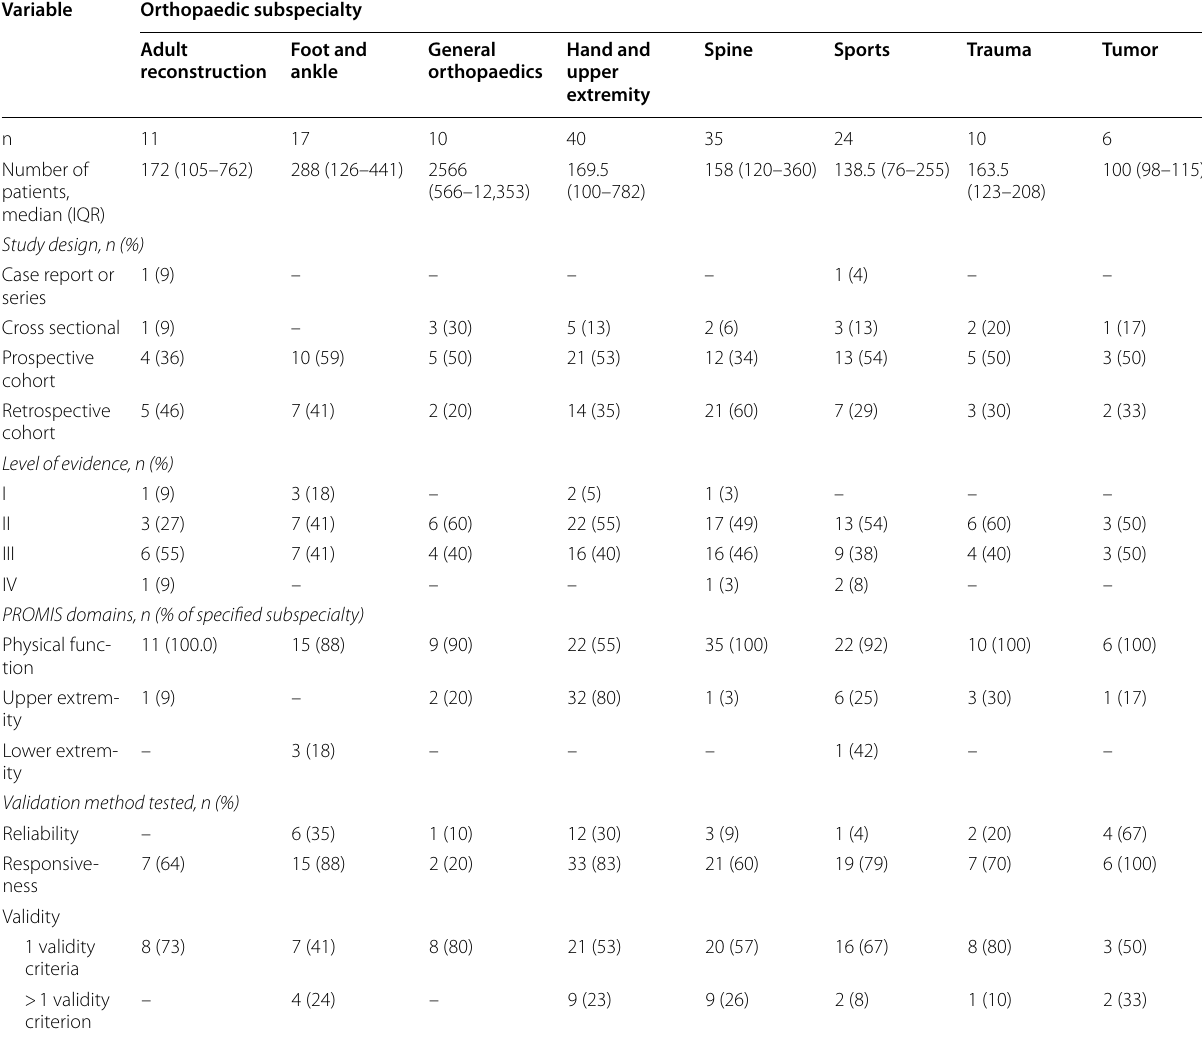
Table 5 Characteristics of publications validating physical health CAT PROMIS domains by orthopaedic subspecialty (includes physical function, upper extremity, lower